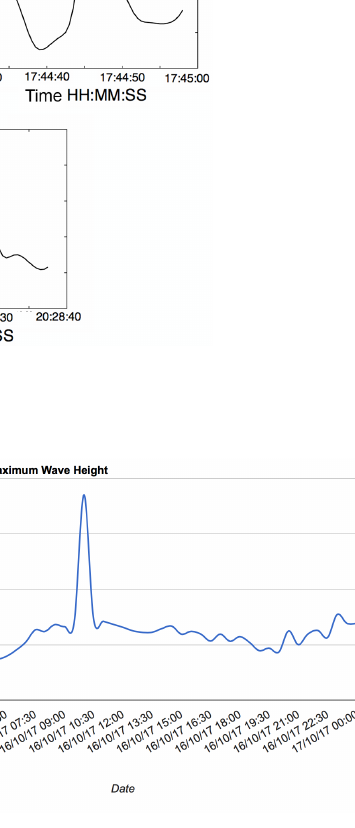
Figure 17. Maximum wave height recordings on the Belmullet Berth A buoy during Storm Ophelia on 16 October 2017. An 18 . 5m rogue wave was recorded with a significant wave height of 4 . 41m. Data retrieved from The Marine Institute